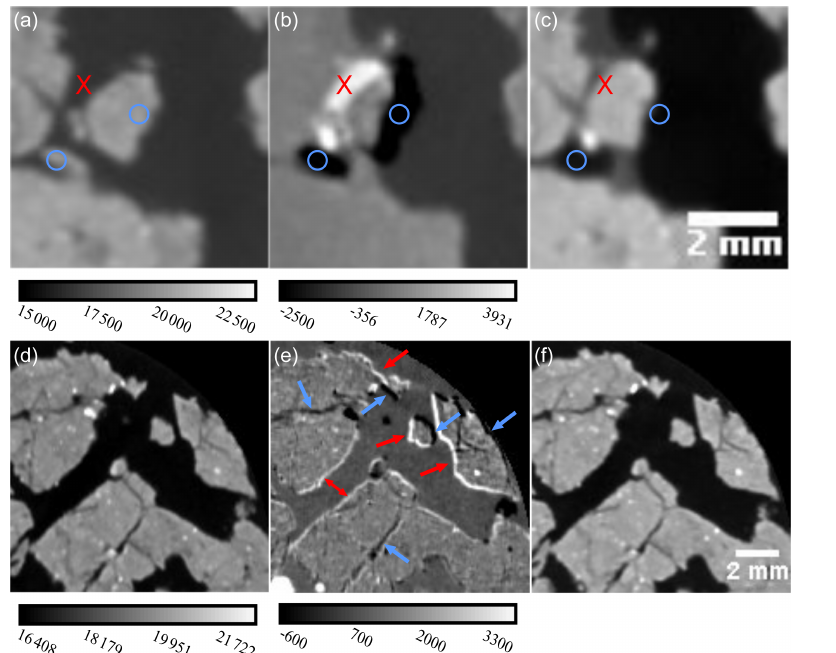
Figure 5. Effect of aggregate movement on the difference image of SNO2 (a, b, c) and SNO3 (d, e, f) . Reference image (a, d) , difference image (b, e) and the image of Ba 2 + -treated soil (c, f) . The red cross and circle indicate the identical coordinates in all three images. The movement of one soil aggregate resulted in very high grey values (red marks) or very low grey values (blue marks) in the difference image. Note that the reference images and the image of Ba 2 + -treated soil share the same grey value calibration bar.